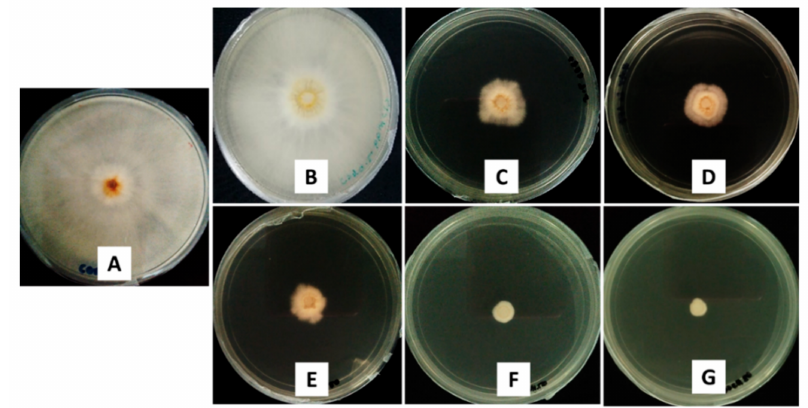
Figure 7. Antifungal e ff ect on G. boninense of the ( A ) control, 50 ppb of ( B ) CEN, ( C ) pure hexaconazole and chitosan–hexaconazole nanoparticles prepared at various concentrations of TPP, ( D ) 2.5, ( E ) 5, ( F ) 10, and ( G ) 20 mg / mL, seven days after incubation at 28 ± 2 ◦ C.